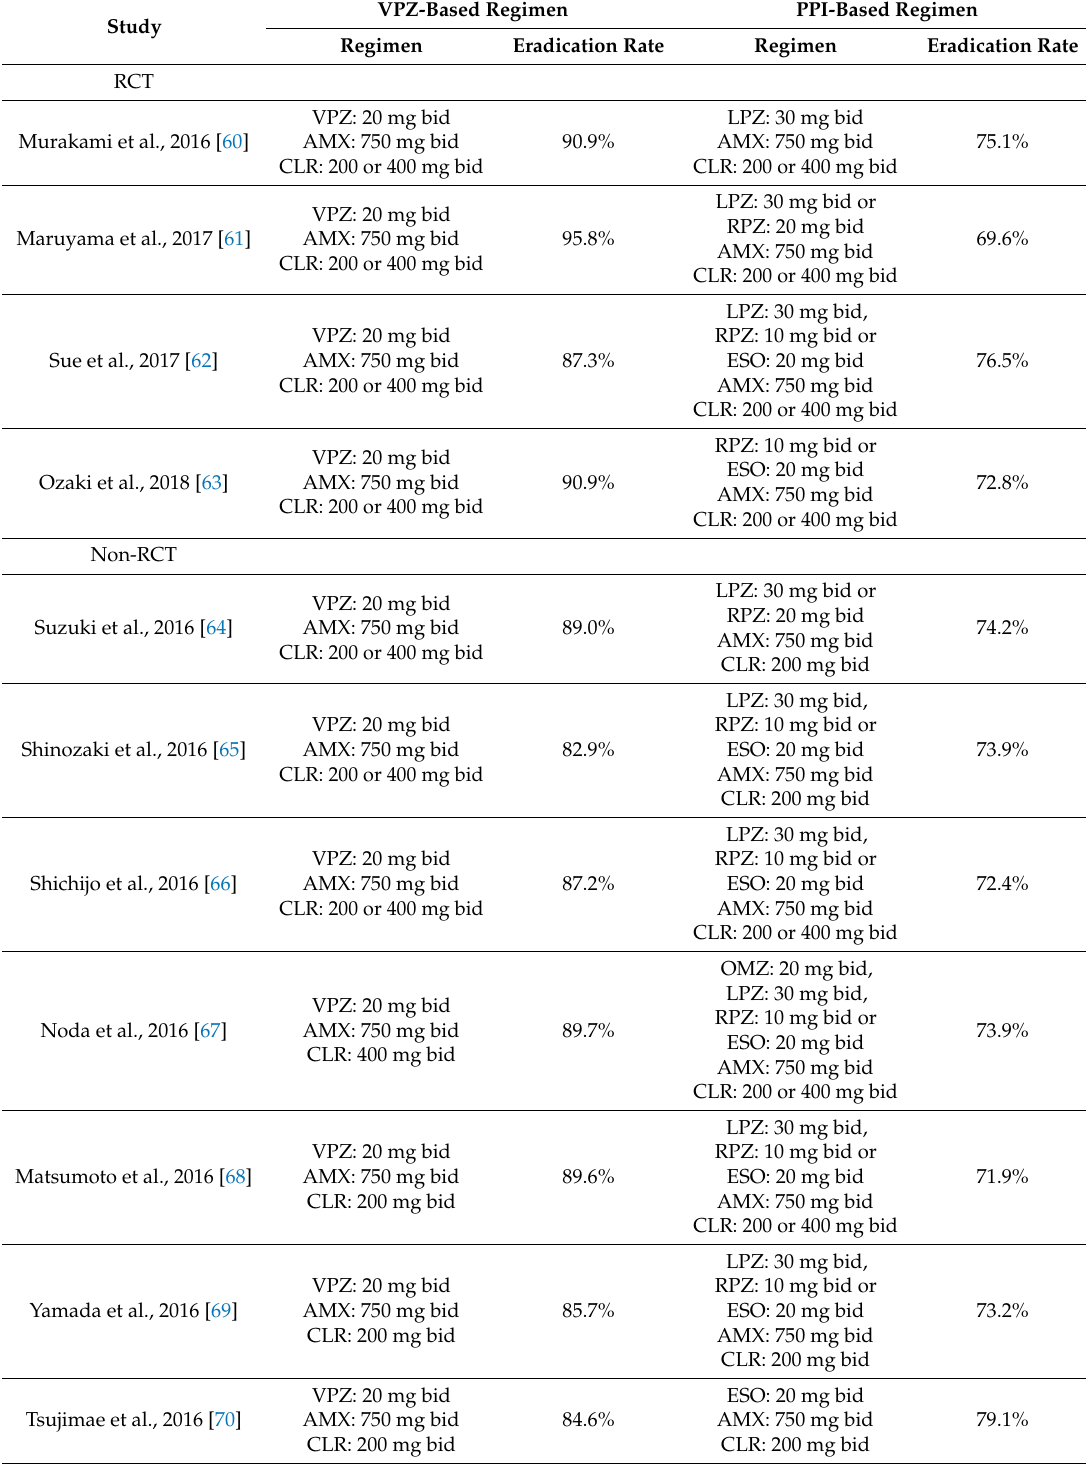
Table 3. Review of Comparative Studies First-line H. pylori Eradication